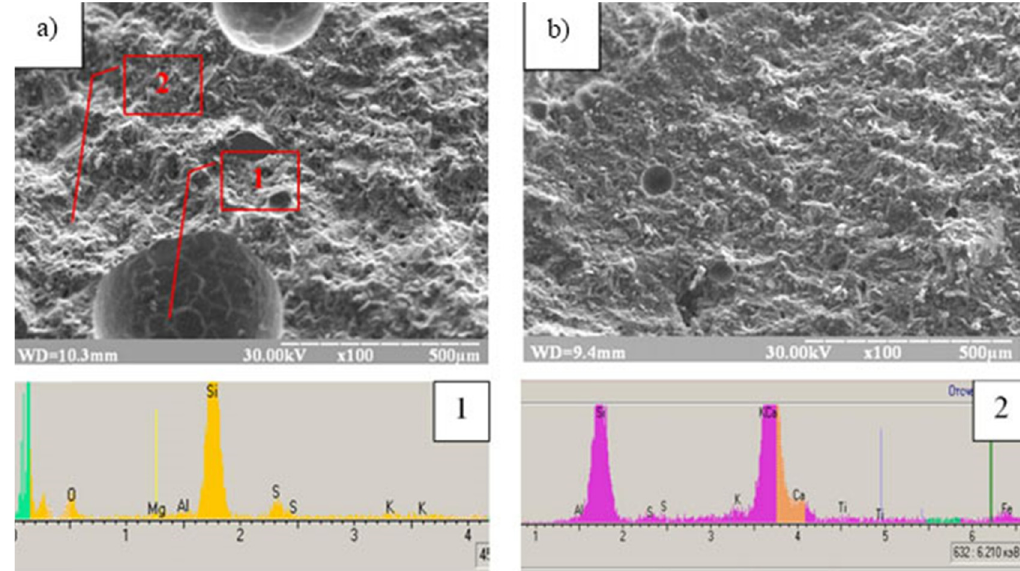
Figure 7: Appearance and EDS of cement paste samples: ( a ) CNTs are dispersed in the PNS medium and ( b ) CNTs are dispersed in the HMWOC medium.